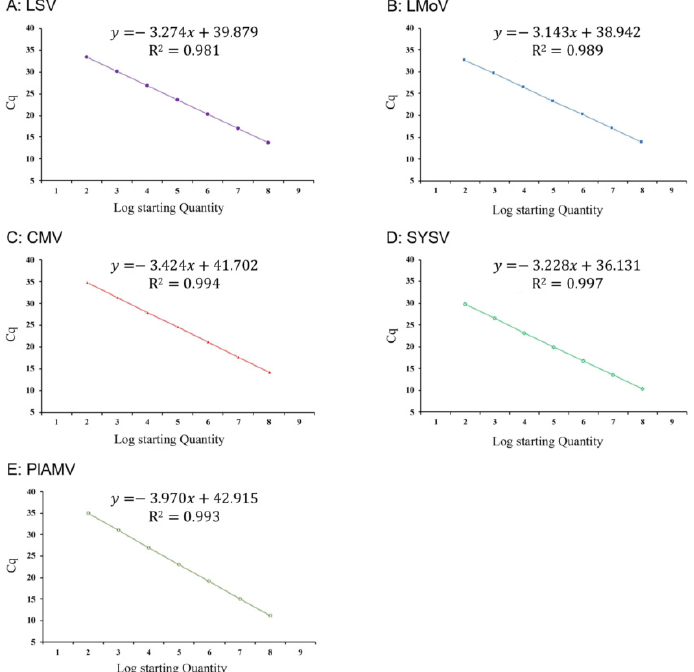
Figure 4. Standard curves obtained by multiplex TaqMan real-time PCR assay for LSV ( A ), LMoV ( B ), CMV ( C ), SYSV ( D ), and PlAMV ( E ).